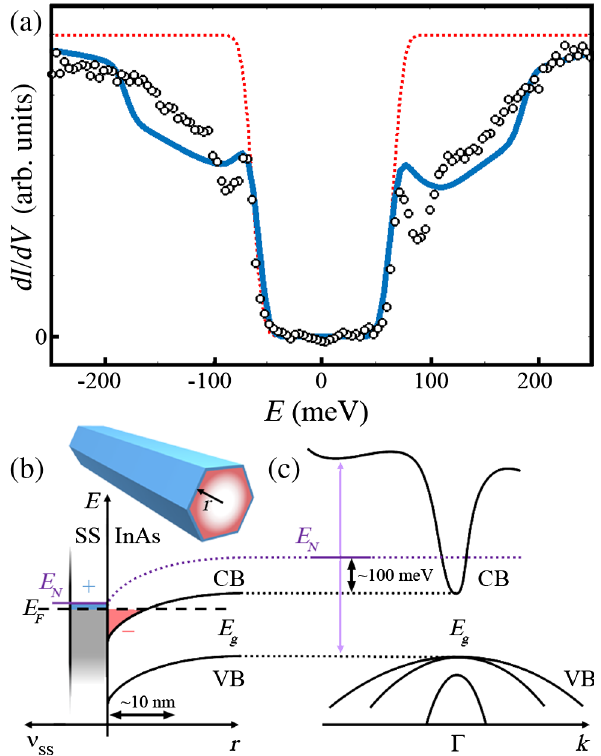
FIG. 4. Low-energy dI=dV signal (circles) fitted with the simplified model (dotted line) and the model that accounts for the energy-dependent transmission through the interface, T (solid line). (b) Schematic band diagram illustrating the positively charged surface states (SS) versus negatively charged accumu- lation layer. Inset shows schematically the radial charge distri- butions at the nanowire surface. (c) InAs band structure in which the neutrality point of the surface states E of the indirect gap, and thus lies 100 meV into the conduction